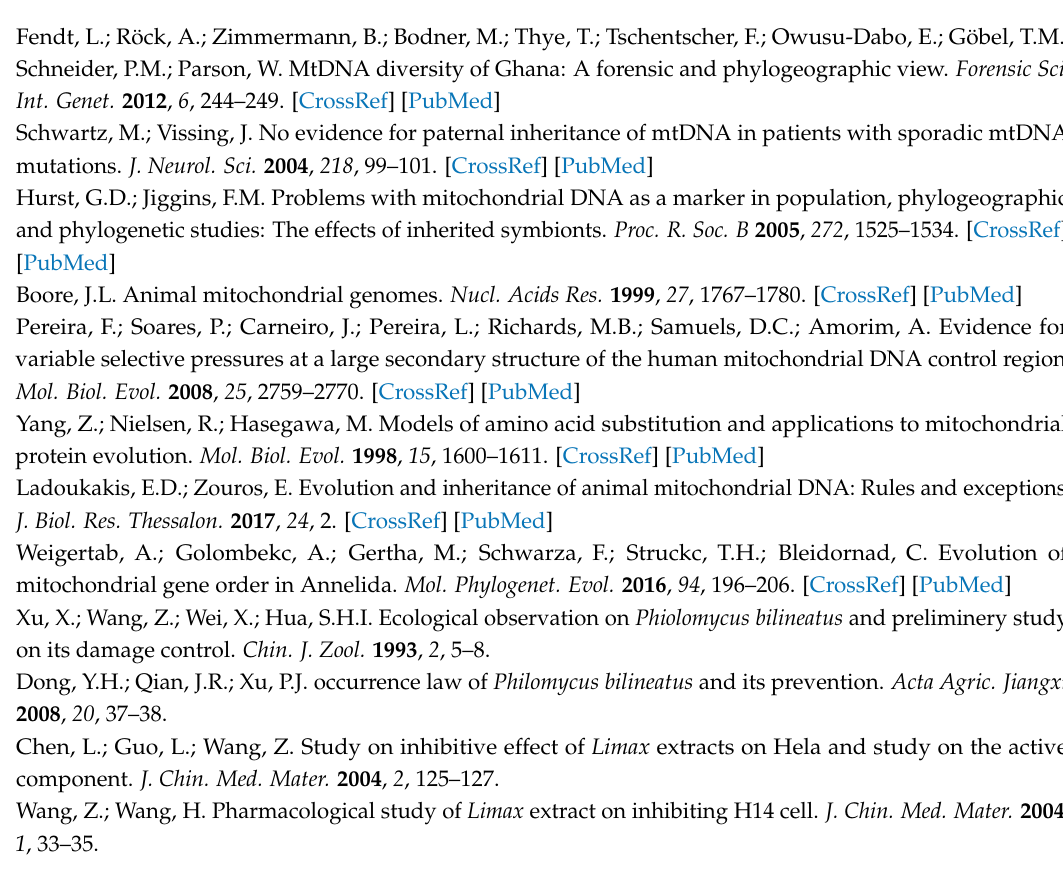
Table S1: List of primers used in cloning the mitochondrial genome of P. bilineatus , Table S2: List of the complete mitogenomes of the Gastropoda